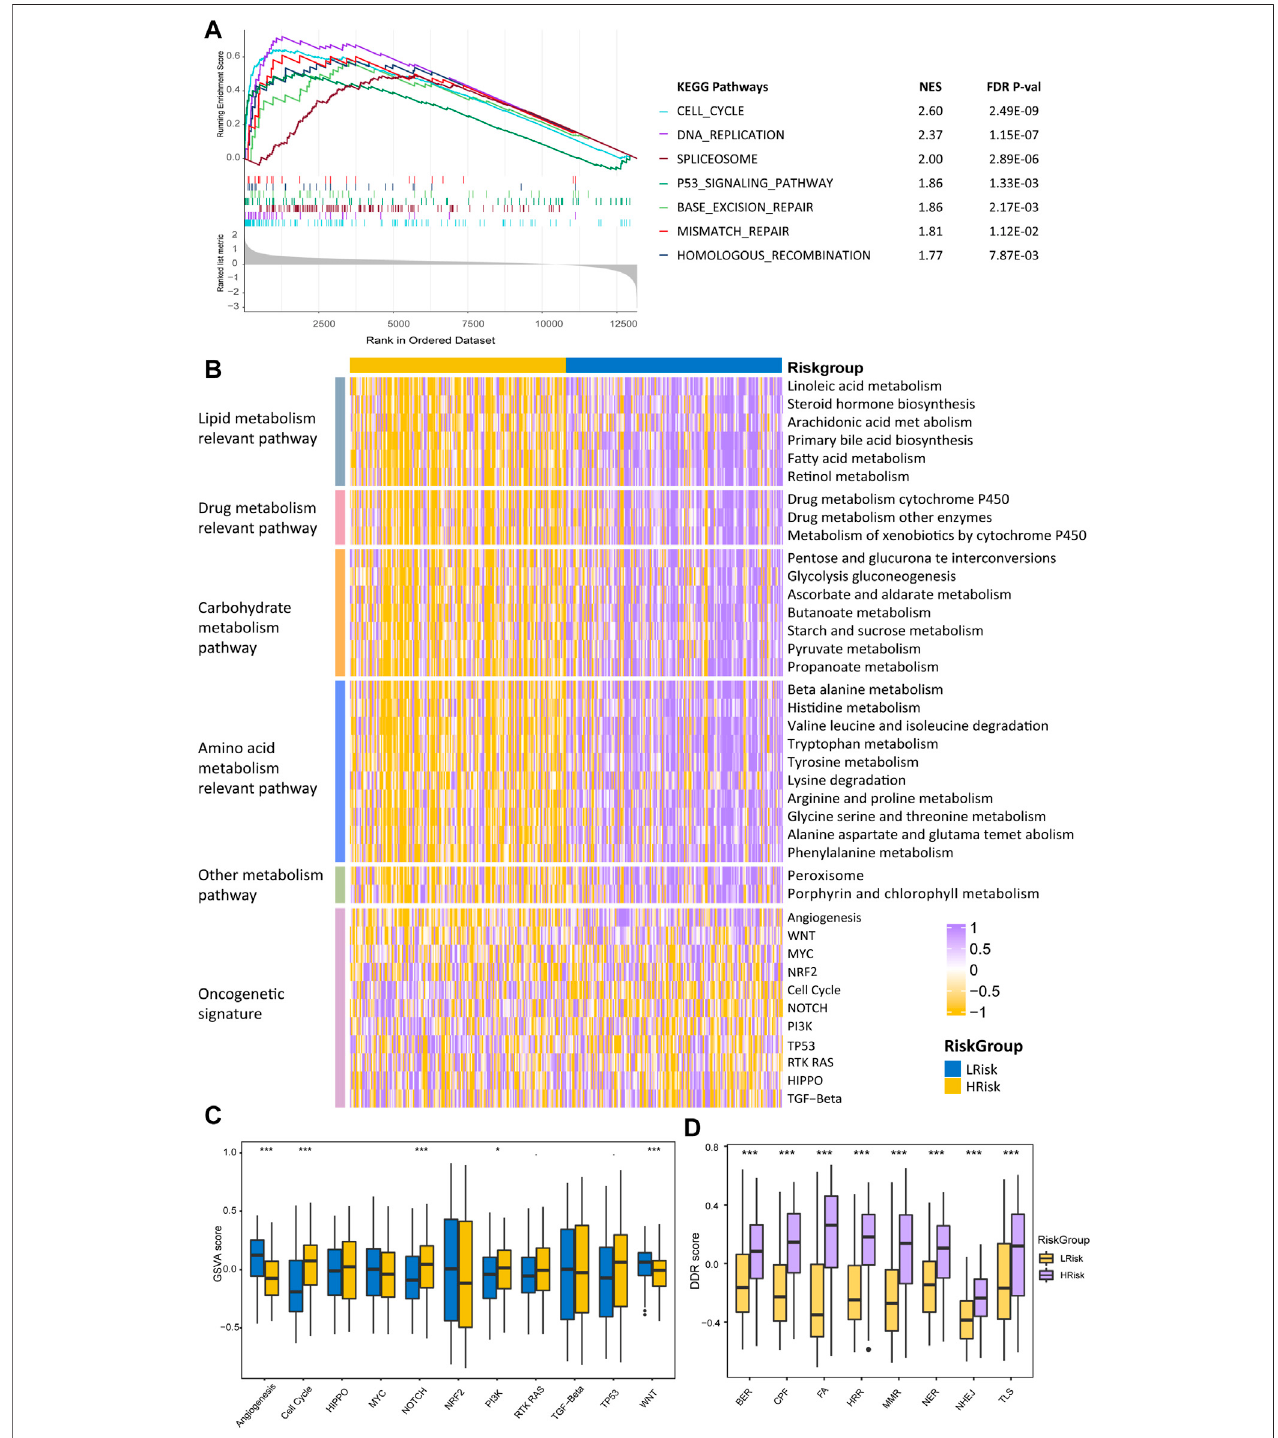
FIGURE 6 | Differentially functional pathways between the HRisk and LRisk group in TCGA. (A) GSEA identi fi ed upregulated pathways in HRisk. (B) Heatmap of enrichmentlevelcalculatedbyGSVAformetabolism-relatedpathwaysderivedfromGSEAandoncogenicpathways. (C,D) Boxplotofoncogenicpathways (C) andDDR pathways (D) from GSVA of two riskgroups. Statistical p values were calculated by the Wilcoxon test and represented by. < 0.1, * < 0.05, ** < 0.01, and *** < 0.001.